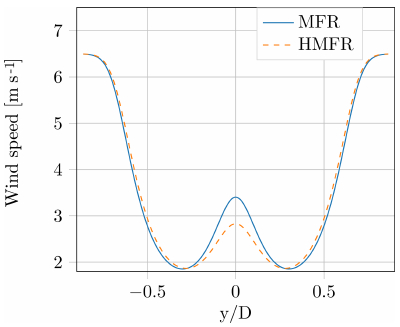
Figure 4. Wind speed deficit at a downstream distance of 2 . 5 D and an ambient turbulence intensity of